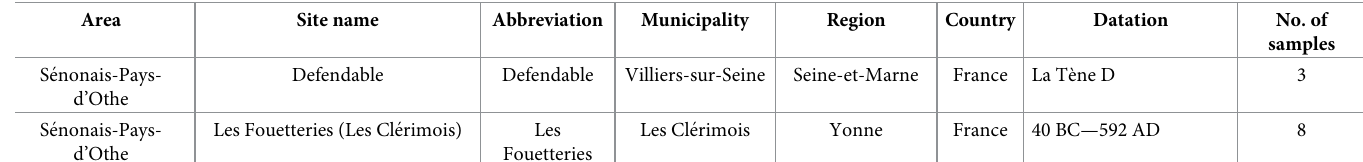
especially during Roman times. From this area, 23 slag samples were analyzed, taken from three protohistoric sites and six Roman sites. Se´nonais-Pays-d’Othe resembles Puisaye geologi- cally and geographically, but is lesser-known [38,39]. This 1,500-sq. km region is probably an